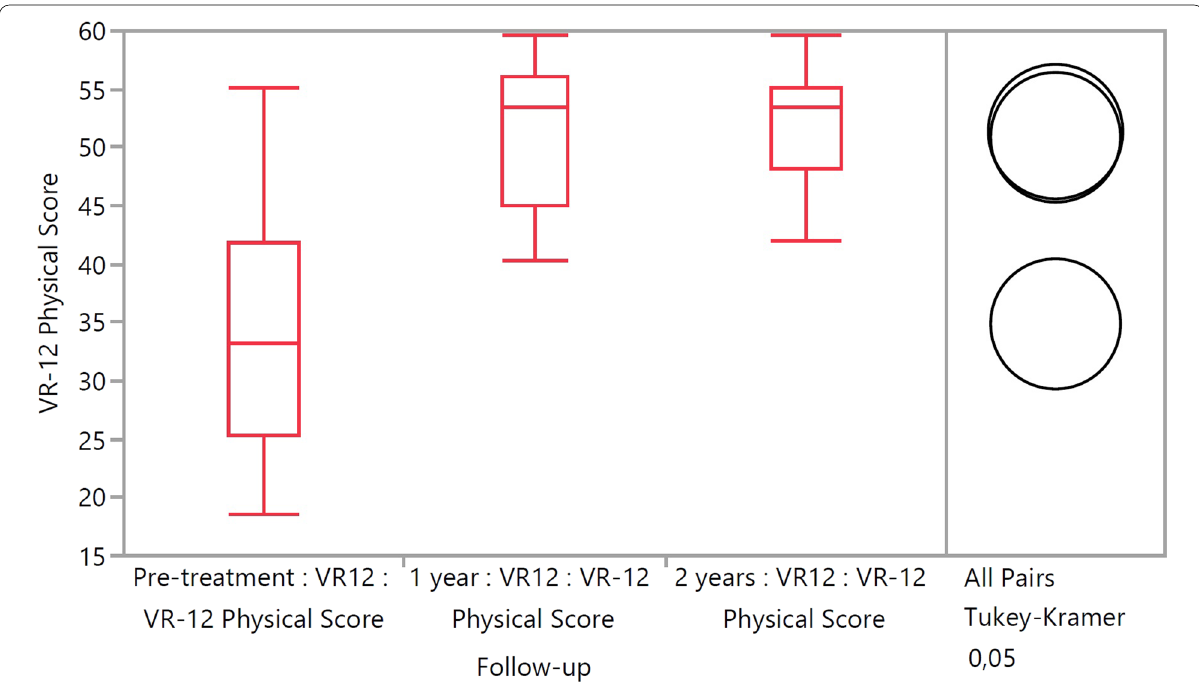
Fig. 4 Chart demonstrating the VR-12 physical scores at the different time intervals